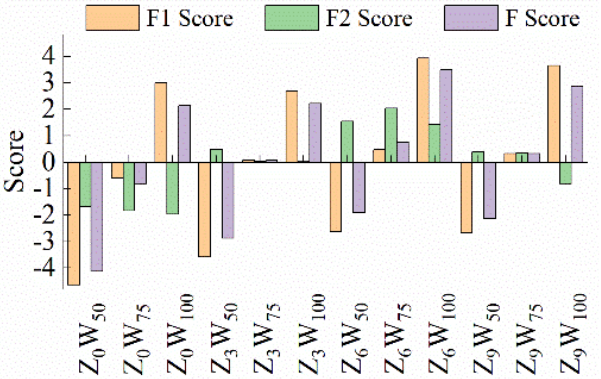
Figure 6. Comprehensive evaluation score of tomato planting under different W ‐ Z conditions.